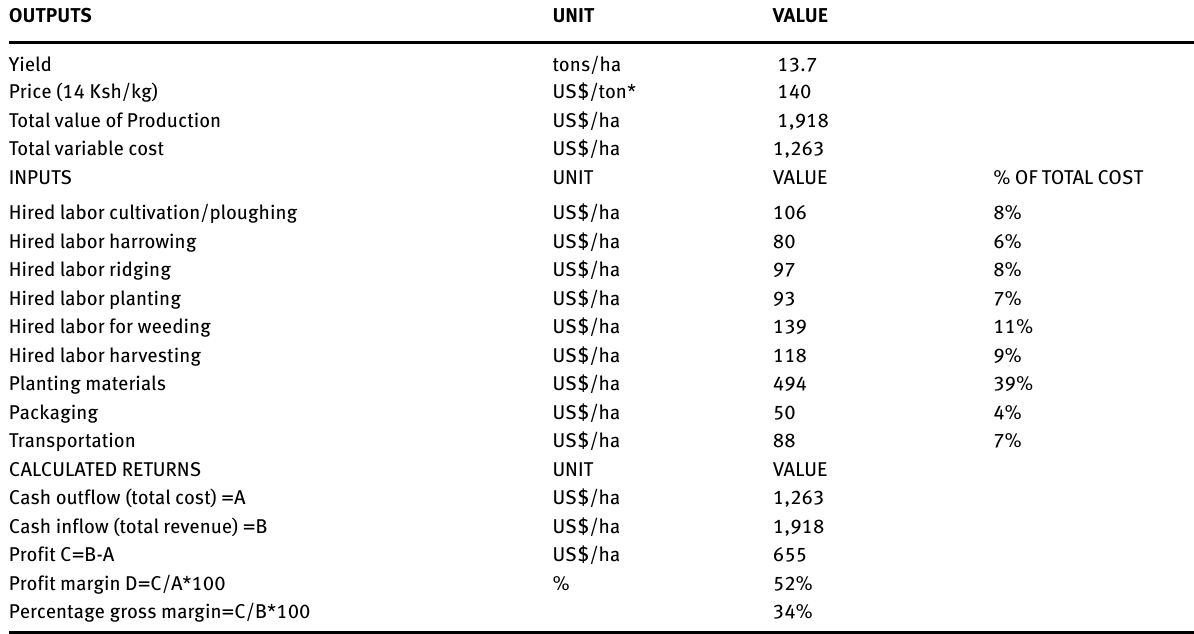
Table 1: Sweetpotato root production gross margin analysis model in Western Kenya